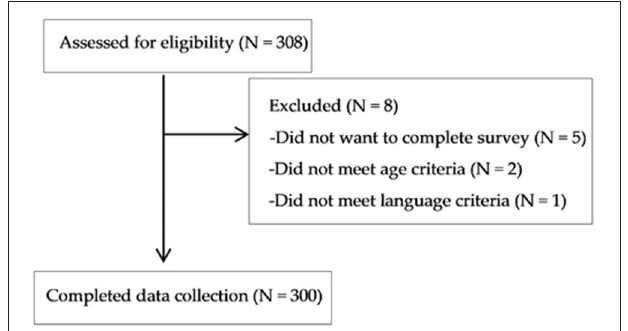
FIGURE 1 | A flowchart of participant